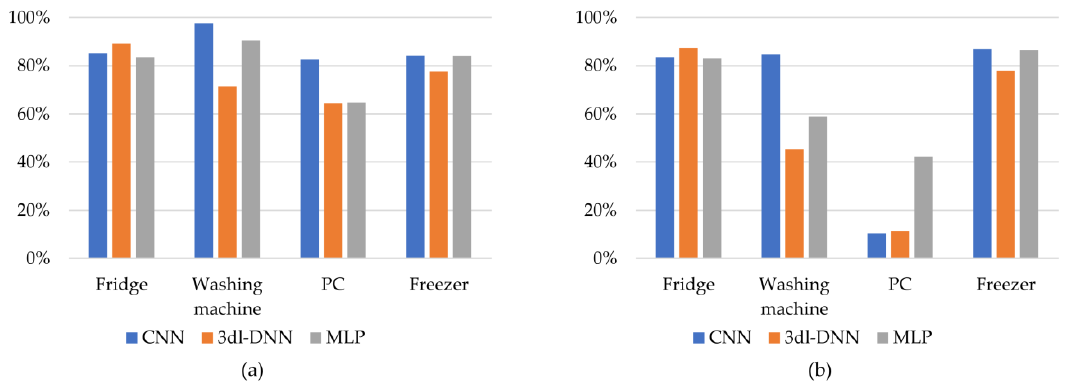
Figure 9. Models’ performance in terms of: ( a ) accuracy (%), ( b ) F 1 -measure (%).